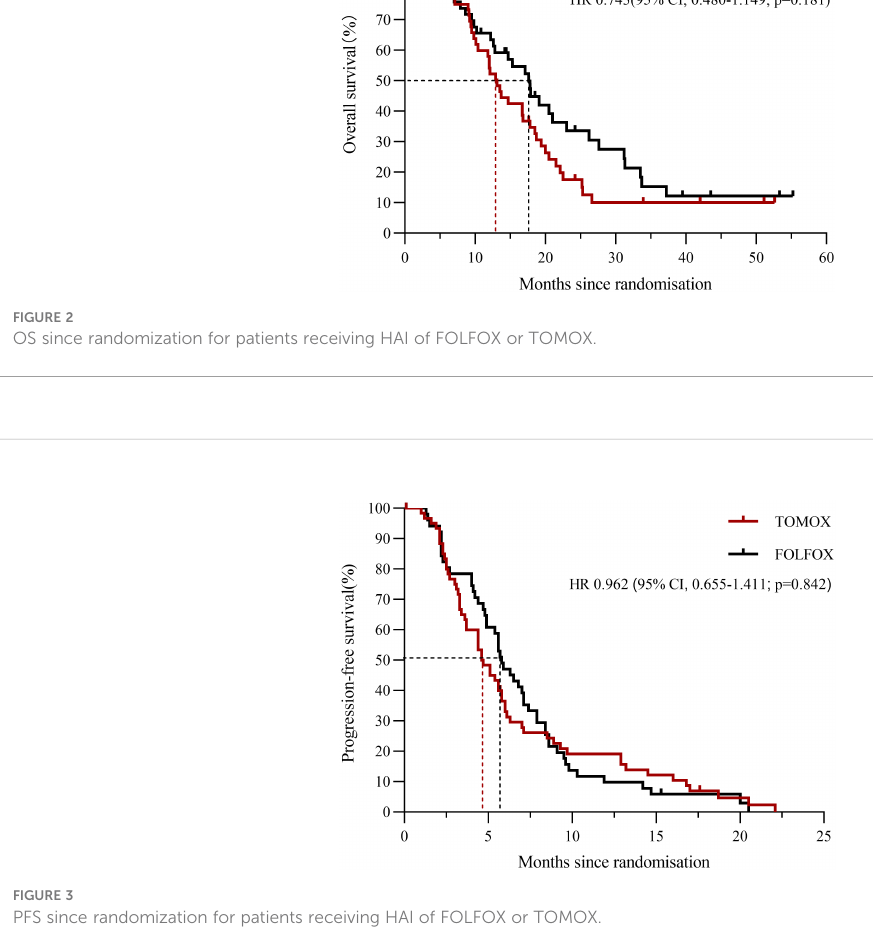
The median PFS and median OS 2.5 and 8.0 months,